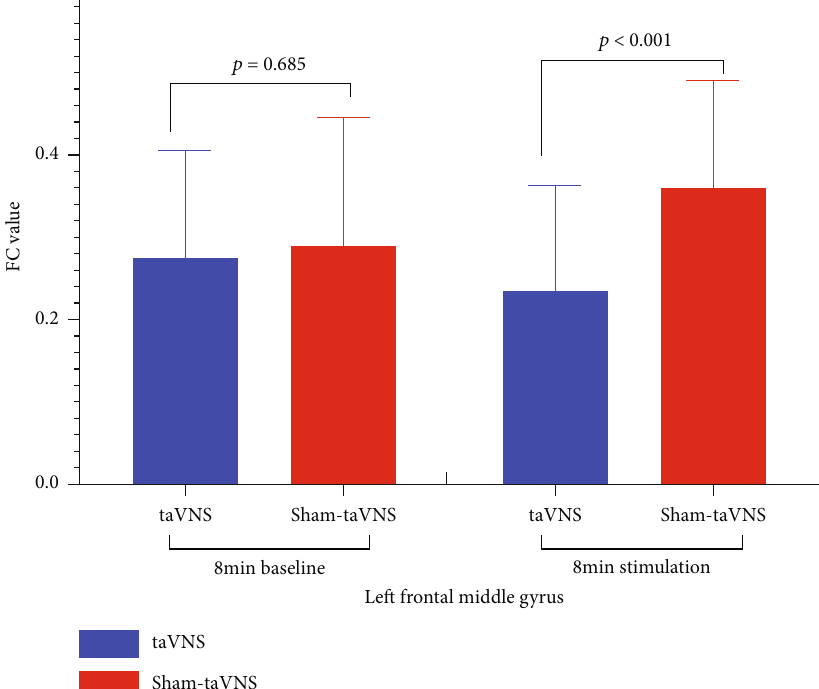
Figure 7: The functional connectivity (FC) comparisons of the right amygdala in di ff erent states and stimulations. A paired t -test was used. If p < 0 : 05 , the di ff erence was statistically signi fi cant. Before stimulation, there was no statistical signi fi cance for the FC of the right amygdala and left middle frontal gyrus (taVNS vs. staVNS), but the di ff erence was signi fi cant during stimulation. The FC decreased in taVNS and increased in staVNS (prestimulation vs. during stimulation). Therefore, the changing trend of the FC was opposite between taVNS and